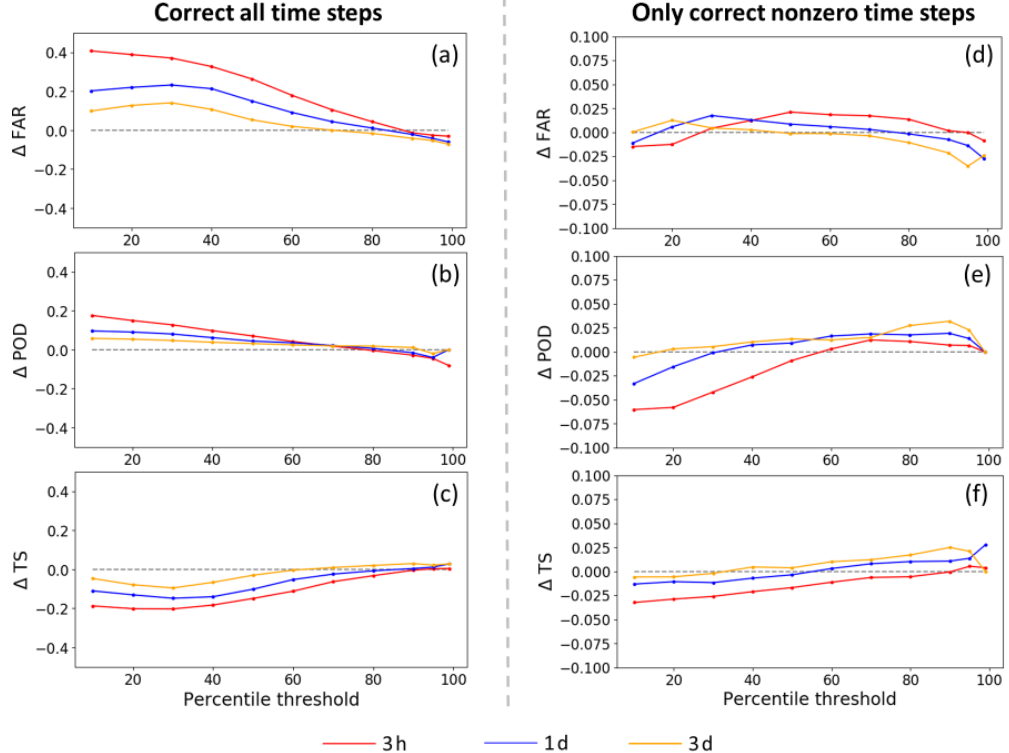
Figure 4. Change in categorical metrics (FAR, POD, and TS) before and after SMART correction for every 3h and every 1 and 3d accu- mulation periods. Metrics at different rainfall thresholds are shown on the x axis (e.g., the 80th percentile means that an event is defined as exceeding the 80th percentile of nonzero rainfall accumulation over the listed time accumulation period). Shown in (a–c) are the SMART rainfall-corrected data at all time steps; shown in (d–f) are the SMART rainfall-corrected data only at nonzero time steps. Note that the y -axis range is different for the two